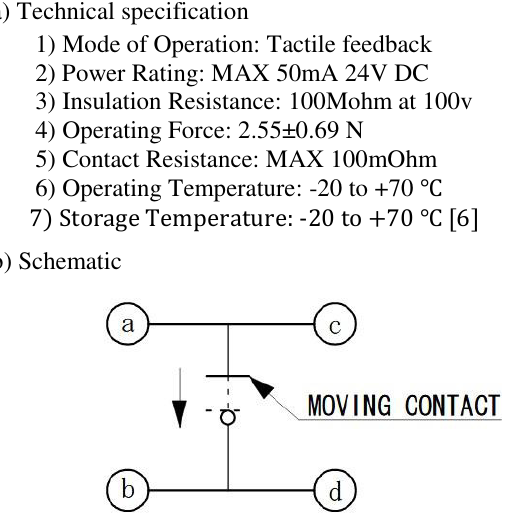
Figure 7. Schematic diagram of push